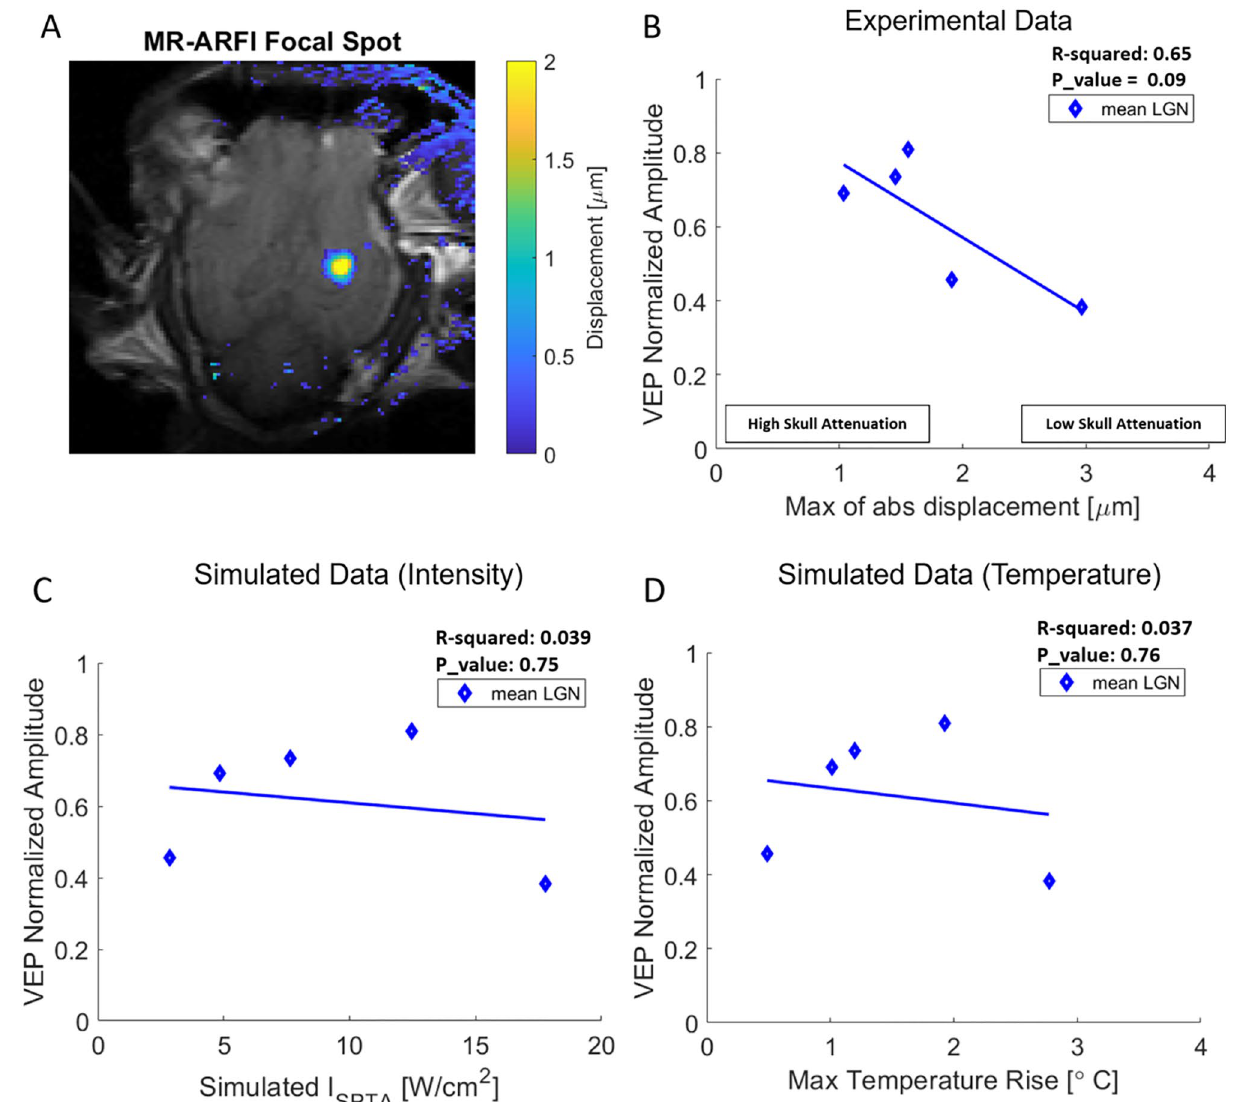
Figure 4. MR-ARFI displacement correlates with VEP suppression. ( A ) Representative MR-ARFI displacement at control focal spot. ( B ) Normalized peak-to-peak VEP amplitude measurements for the mean LGN (average of VEP amplitudes for LGN 1 and LGN 2) as a function of maximum MR-ARFI displacement at the focal spot. Normalized peak-to-peak VEP amplitude versus simulated intensity ( C ), and maximum temperature rise ( D ). Figures in panels C and D show no correlation between the VEP amplitude and the simulated